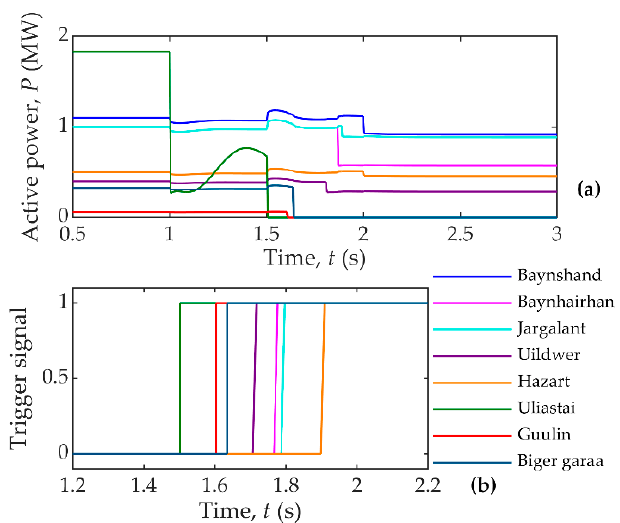
Figure 8. UFRs action in high inertia—summer season scenario: ( a ) active power; ( b ) trigger signal of the UFRs.